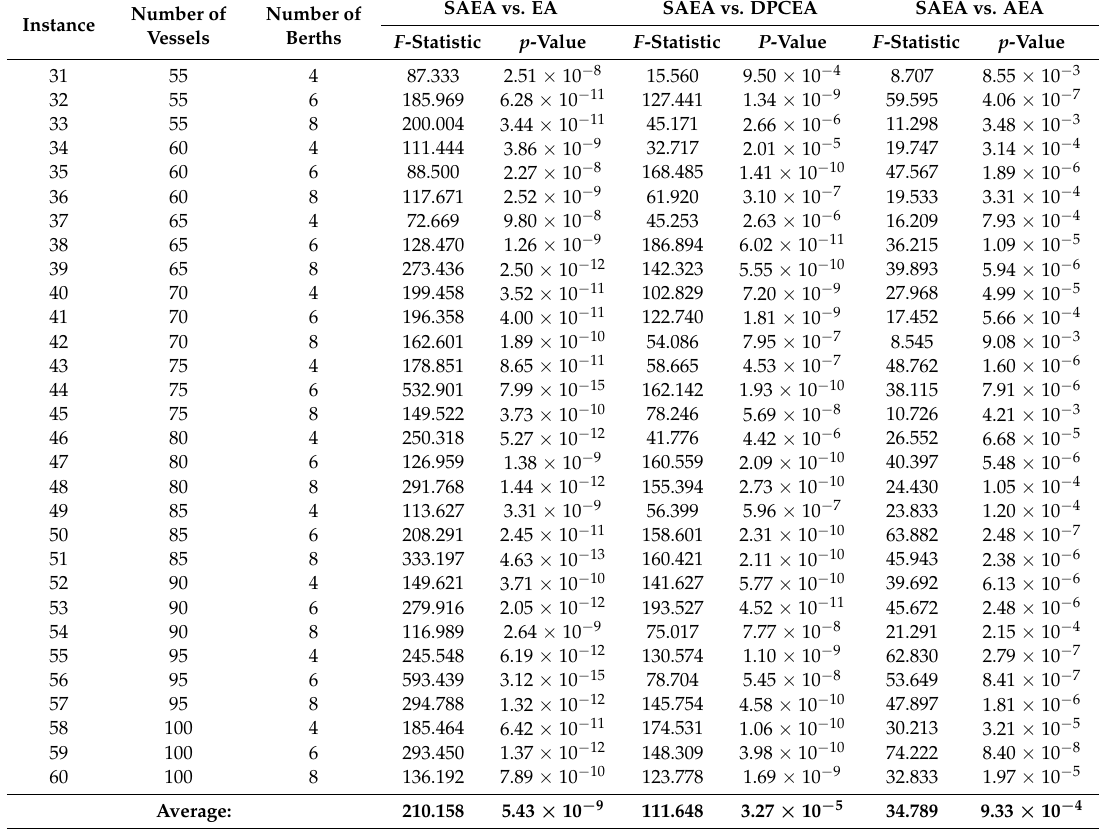
Table 6. The one-way ANOVA analysis